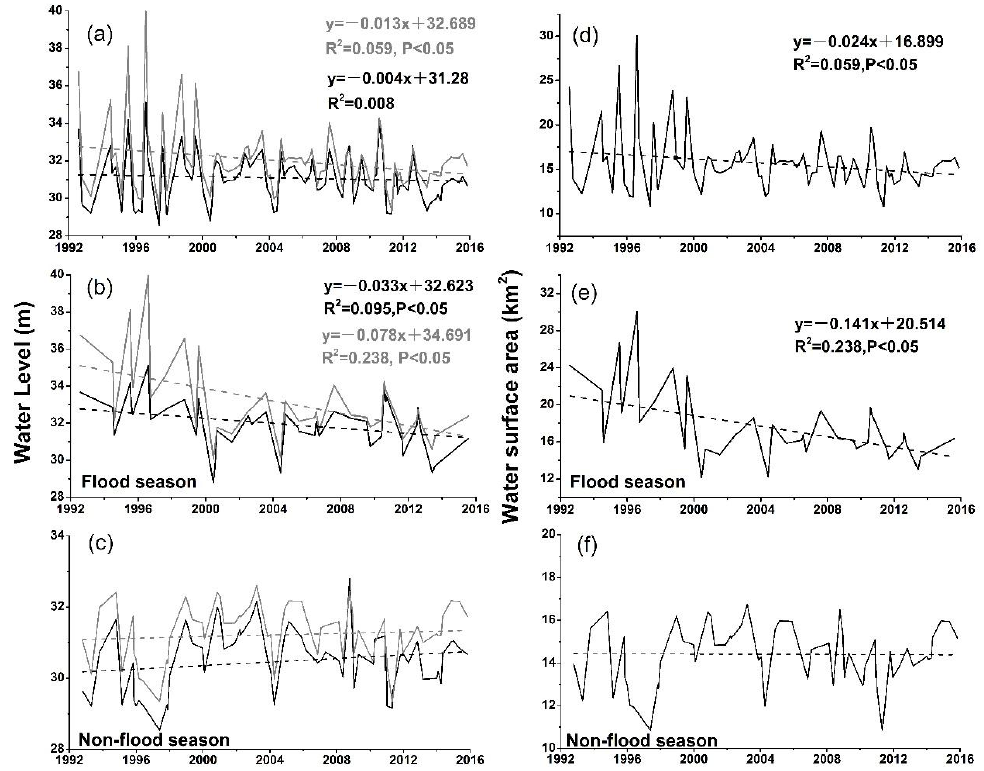
Figure 5. Temporal changes in water level and water surface areas during the flood and non-flood seasons of the Tian-e-Zhou oxbow lake from 1992–2015. ( a , d ) show the total water level and the water surface area variation during 1992–2015, respectively. ( b , e ) show the water level and the water surface area variation in the flood season (from June–September) during 1992–2015, respectively; and ( c , f ) show the water level and the water surface area variation in the non-flood season (from October–May) during 1992–2015, respectively. The black and grey lines in ( a – c ) show the water level extracted by using the WBET and LRC methods, respectively.